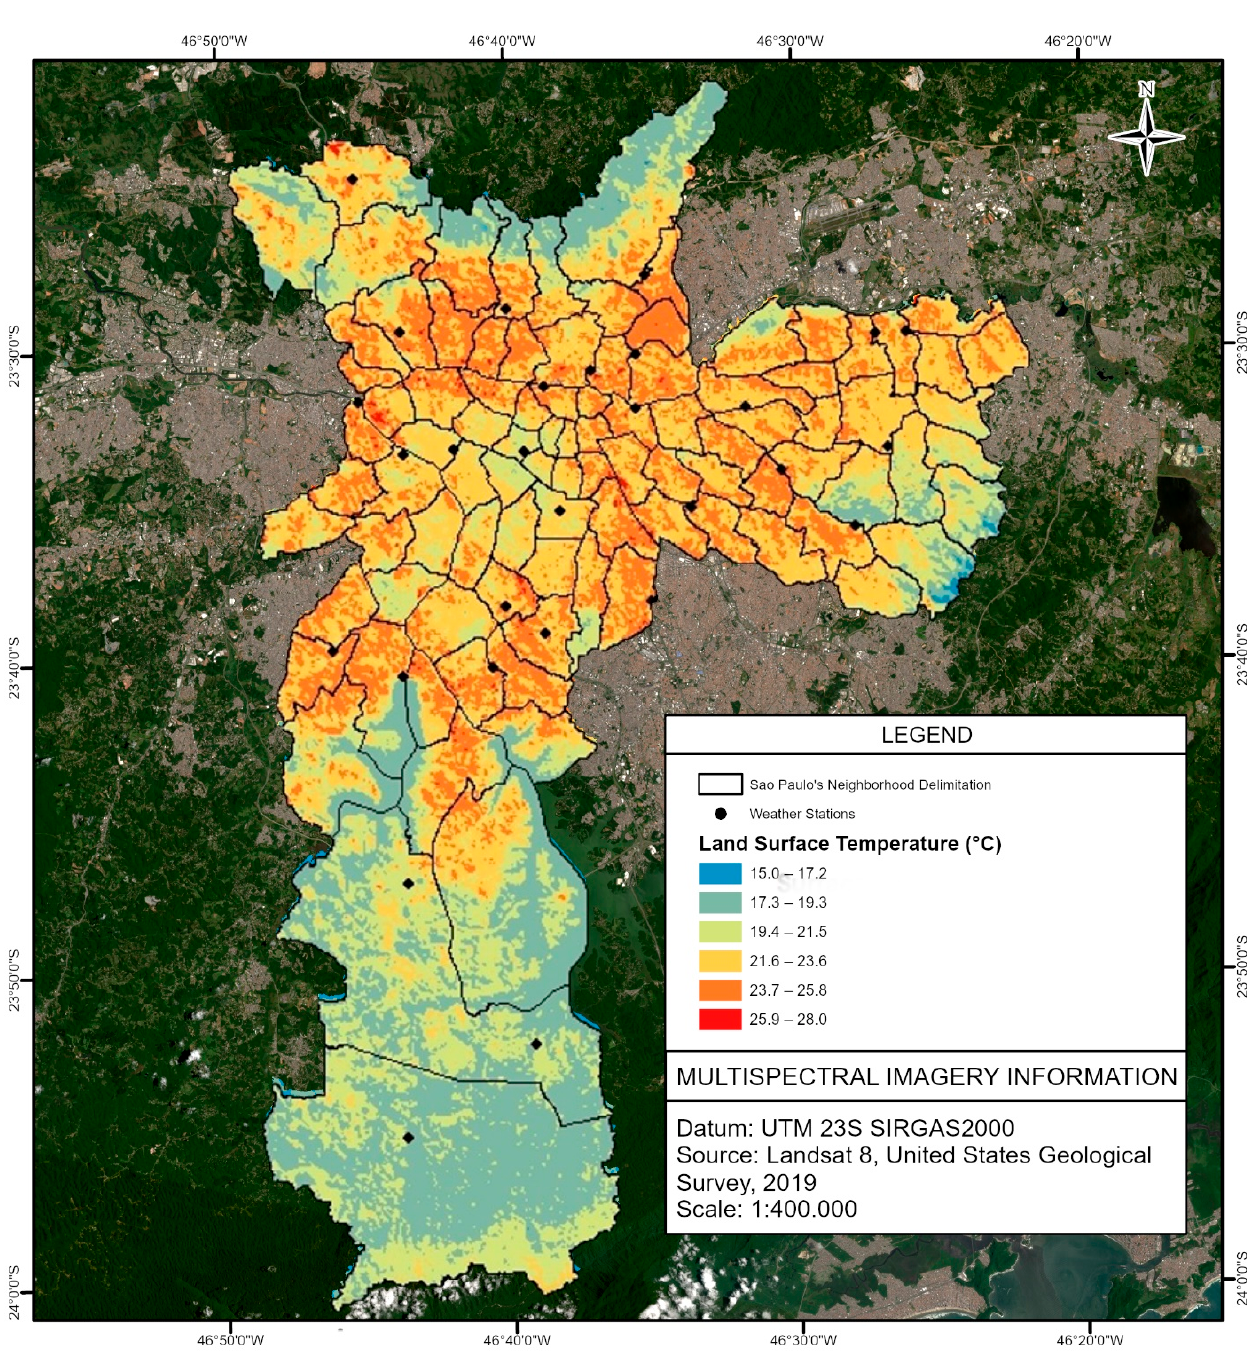
Figure 8. Land surface temperature (°C) in São Paulo City on 17 August 2019 at 1:04 PM using the split window algorithm. Source: Landsat 8, United States Geological Survey. Elaborated by authors (2021).